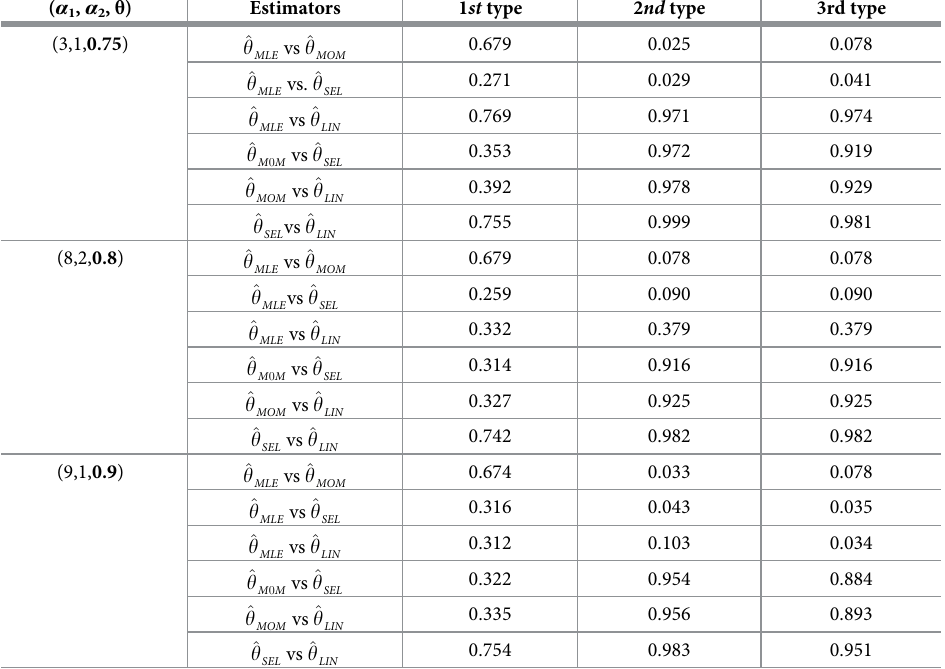
Table 5. PN comparisons based on progressive type II censoring based on three types of censoring with theoretical value of θ >